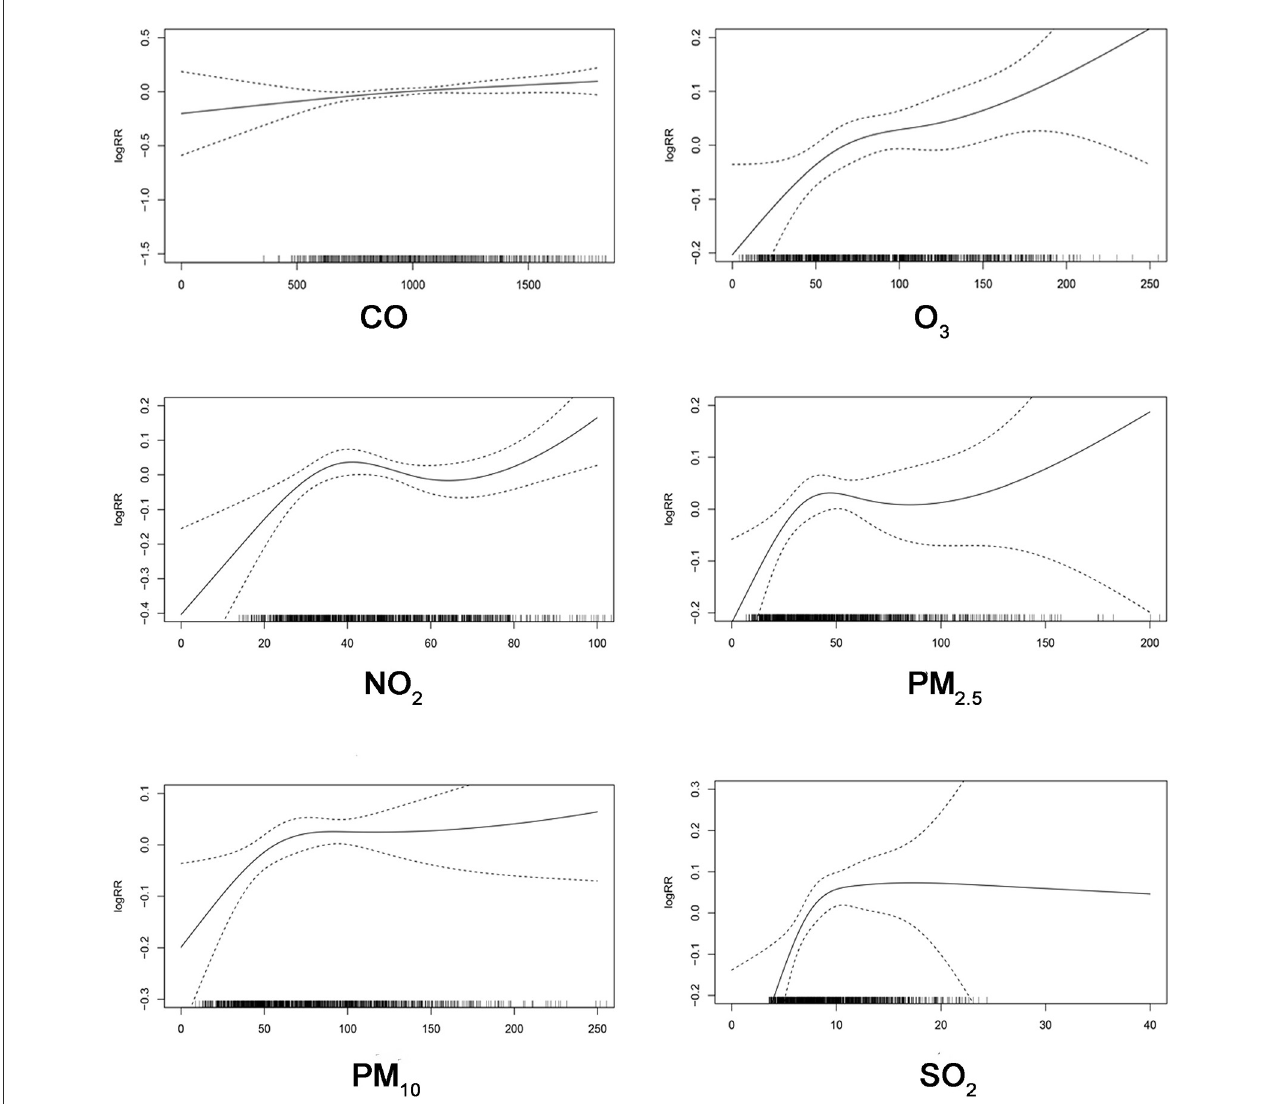
FIGURE5 The exposure-response relationship curves of SO 2, NO 2, PM 2.5, PM 10, CO, and O 3